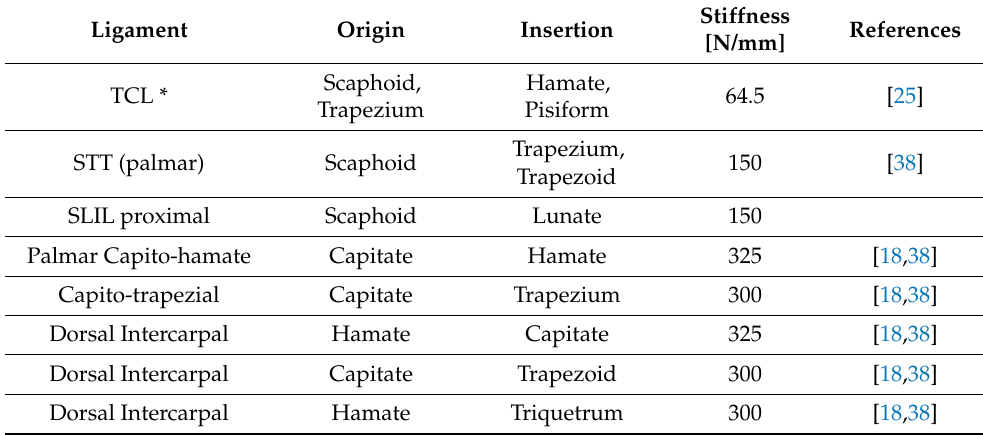
Table A1. Stiffness of ligaments in the finite element